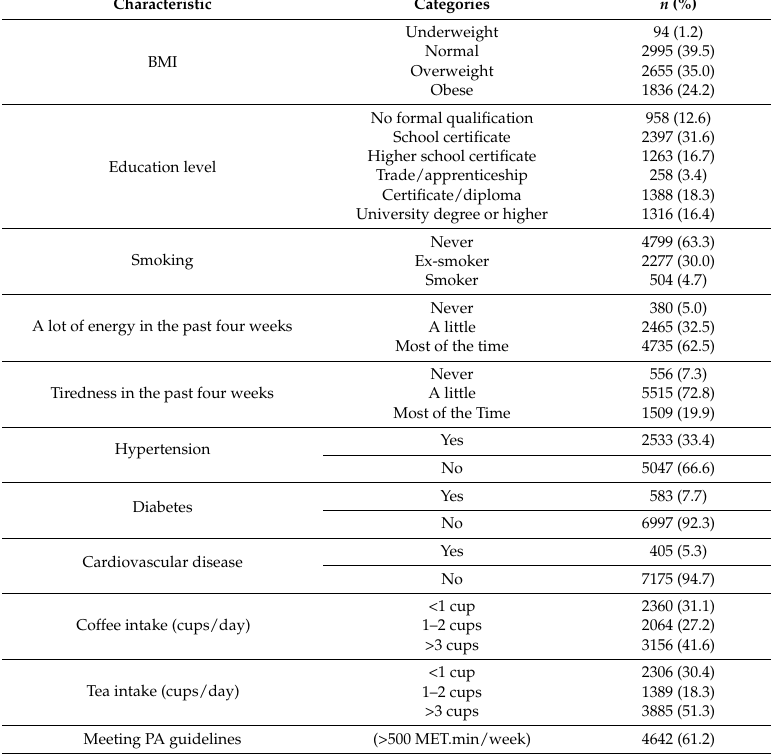
Table 1. Sociodemographic characteristics of 7580 women aged 64.7 ± 1.5 years included in the analysis. BMI, body mass index; PA, physical activity; MET, metabolic